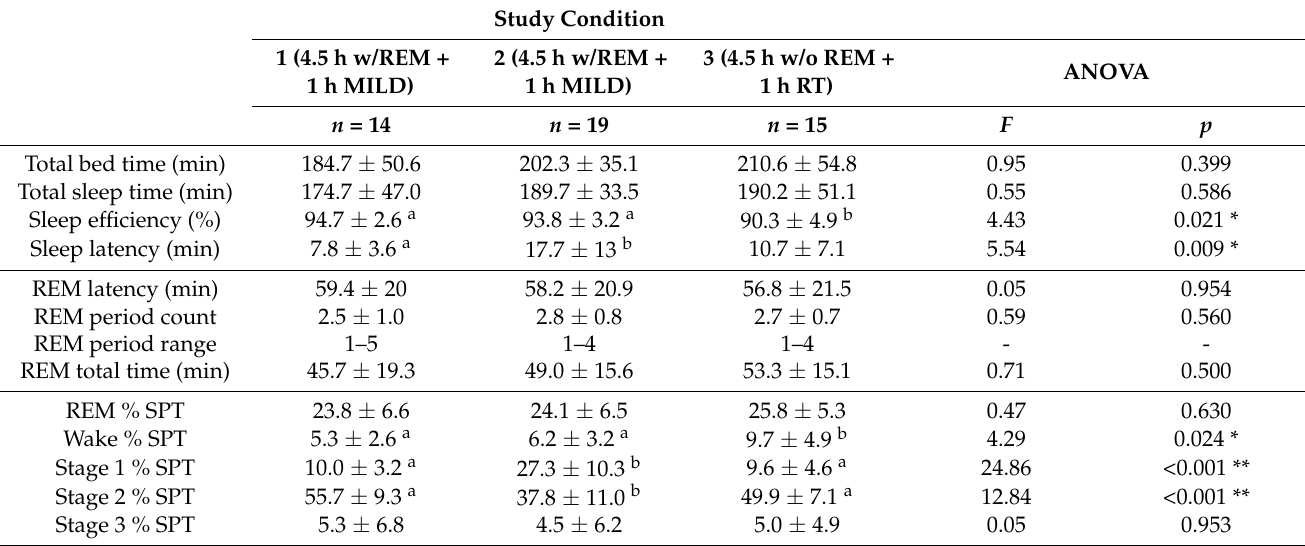
Table 1. Sleep data for the second half of the night of all the participants (experiment 1–3). Study